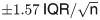
Speed and Corrected Membrane Dynamics are independent.(A) Values for Cell Speed and Dynamic Cell Area are plotted. The density of observations at a given Cell Speed (Cell Speed conditional density) is color-coded following log transformation, enabling better observation of trends in Dynamic Cell Area values given changing Cell Speed. A linear fit (Pearson’s correlation coefficient r = 0.74) of the relationship between Cell Speed and Dynamic Cell Area is indicated (black line). (B) Scatter plot of Cell Speed versus Dynamic Cell Area. Cell observations are divided into Cell Speed quintiles as indicated by color scaling: red (slow, 0%-20%); orange (20%-40%); yellow (moderate, 40%-60%); light-green (60%-80%); green (fast, 80%-100%). (C) Box plots show the median and variability of Dynamic Cell Area per speed quintile. The box shows the quartiles and the whiskers show 1.5 times the interquartile range (IQR). Outliers are not shown. Notches are placed at the median value ±1.57 IQR/n, where n is the number of observations in each quintile (approximation of the 95% confidence interval of the median). By comparing these measures for each Cell Speed quintile we observed a monotonic increase of Dynamic Cell Area with Cell Speed. Colors as in (B). (D) Corrected Membrane Dynamics (CMD) is defined by subtracting the linear relationship between Cell Speed and Dynamic Cell Area from all observations. Conditional density color-coding and linear fit are calculated and displayed as in (A). (E) Scatter plot of Cell Speed versus CMD, color-coded by Cell Speed quintiles as in B. (F) Box plots as in (C) based on Cell Speed quintiles show that there is no trend in CMD as a function of Cell Speed. Box plots structured as in C. Colors as in (B). (G) Scatter plot of Cell Speed versus CMD. The observations were divided into equally sized quintiles of CMD as indicated by color scaling: blue (low, 0%-20%); purple (20%-40%); grey (intermediate, 40%-60%); dark-pink (60%-80%); pink (high, 80%-100%). (H) Box plots as in (C) showing median and variability of Cell Speed per CMD quintile. Colors as in (G). (I) Box plots as in (C) showing median and variability of Dynamic Cell Area per CMD quintile. Colors as in (G).